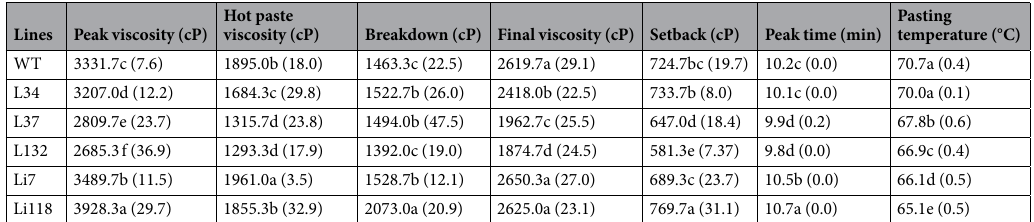
Lines Peak viscosity (cP)